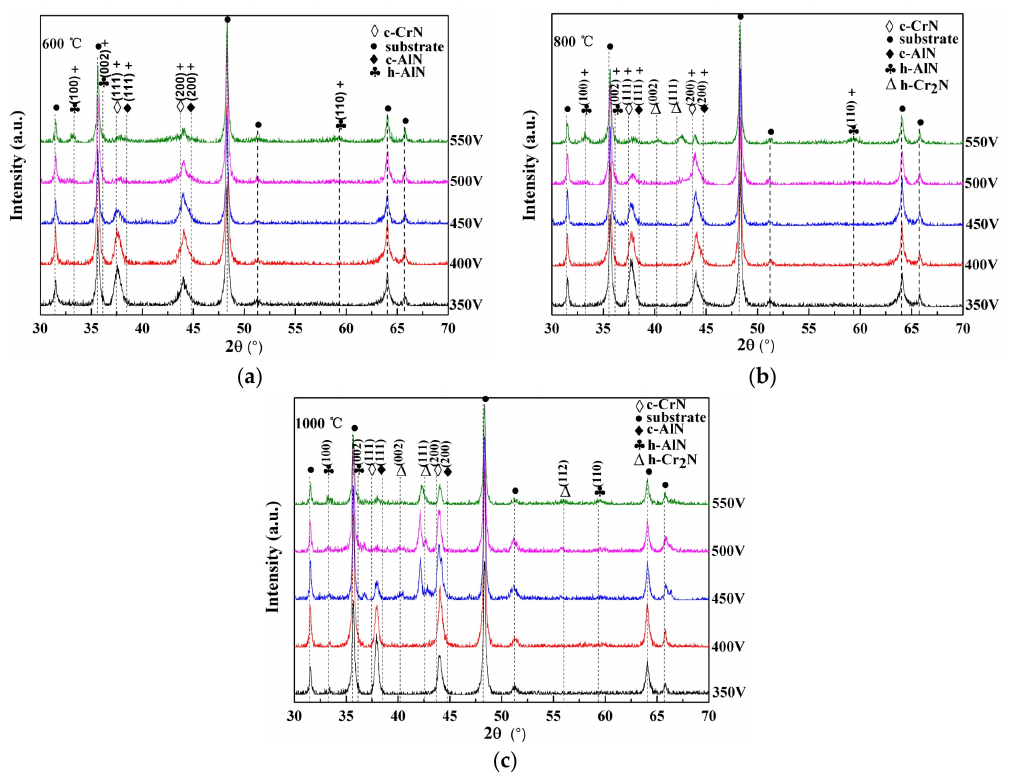
Figure 7. XRD patterns of AlCrN coatings deposited at different charge voltages after vacuum annealing for 2 h at ( a ) 600 °C, ( b ) 800 °C, and ( c ) 1000 °C. “+” denotes the XRD peaks unaltered by the thermal annealing.